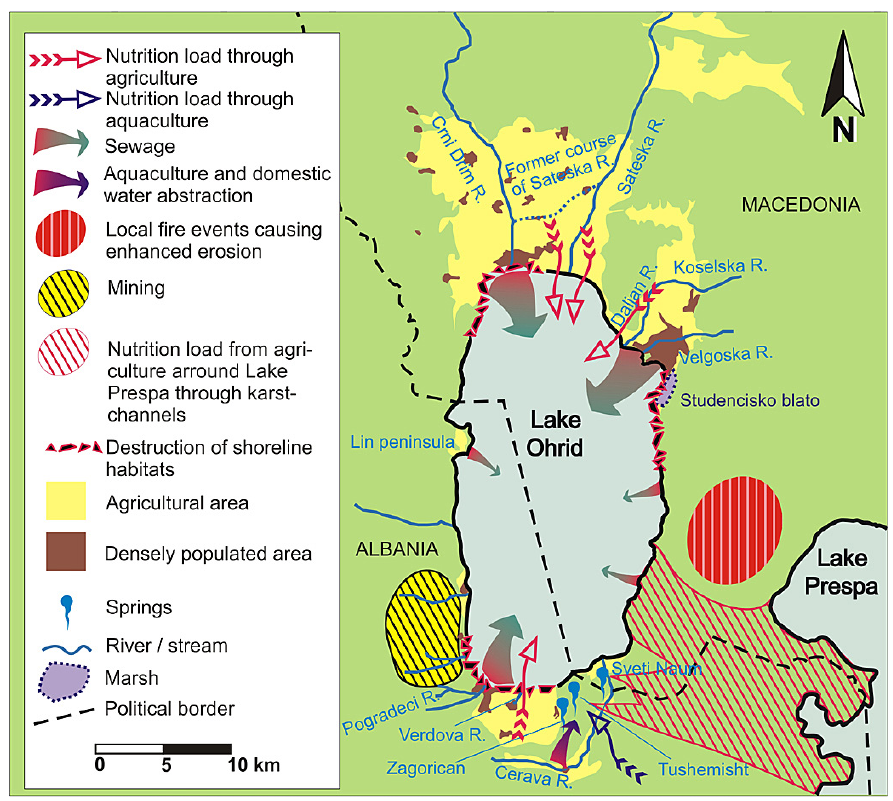
Fig. 1. Land use and spatial distribution of selected major threats to Lake Ohrid (for details see text and Table